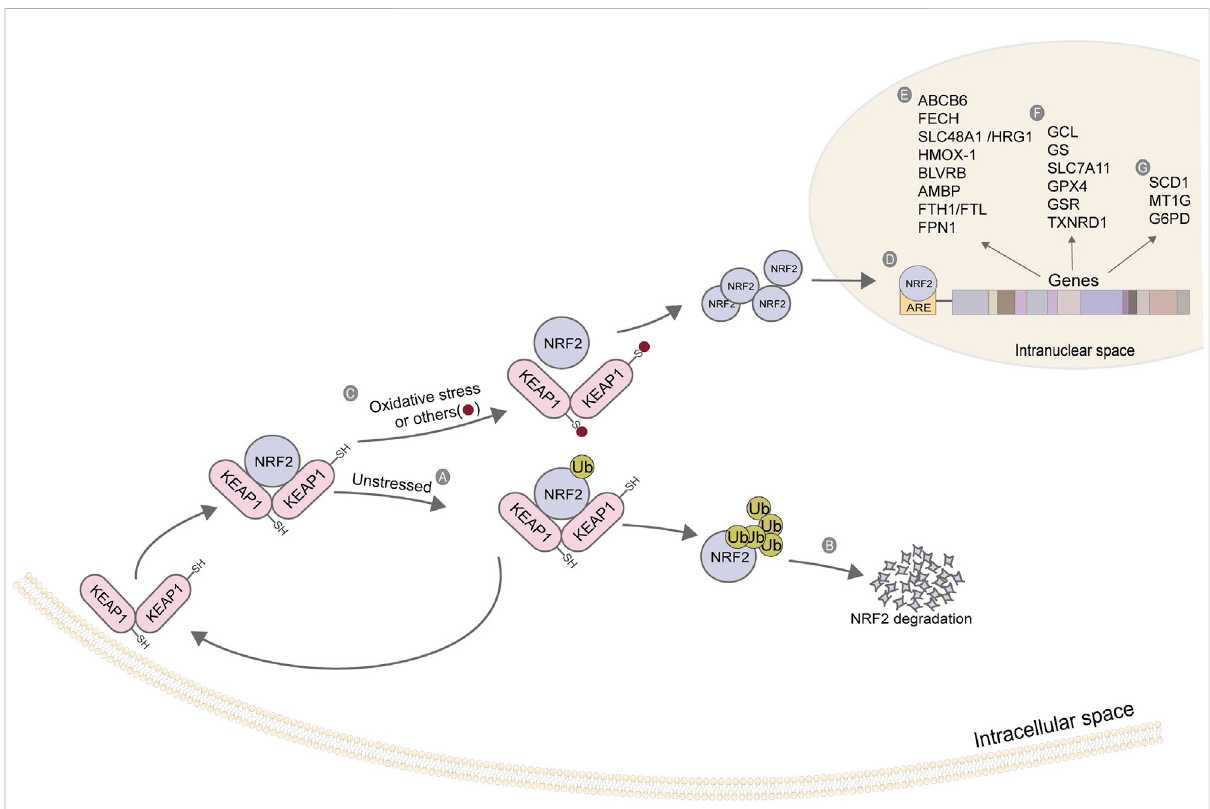
FIGURE 4 Action mechanism and regulatory genes of NRF2. (A) KEAP1 binds to NRF2, and NRF2 initiates ubiquitination under a non-stress state; (B) The ubiquitination of NRF2 strengthens its degradation; (C) Depolymerization of KEAP1-NRF2 complex under oxidative stress; (D) NRF2 enters the nucleus and binds to ARE; (E) Iron ion metabolism-related gene; (F) Glutathione metabolism-related genes; (G) Other related genes. The fi gure modi fi ed from (Kerins and Ooi, 2018).